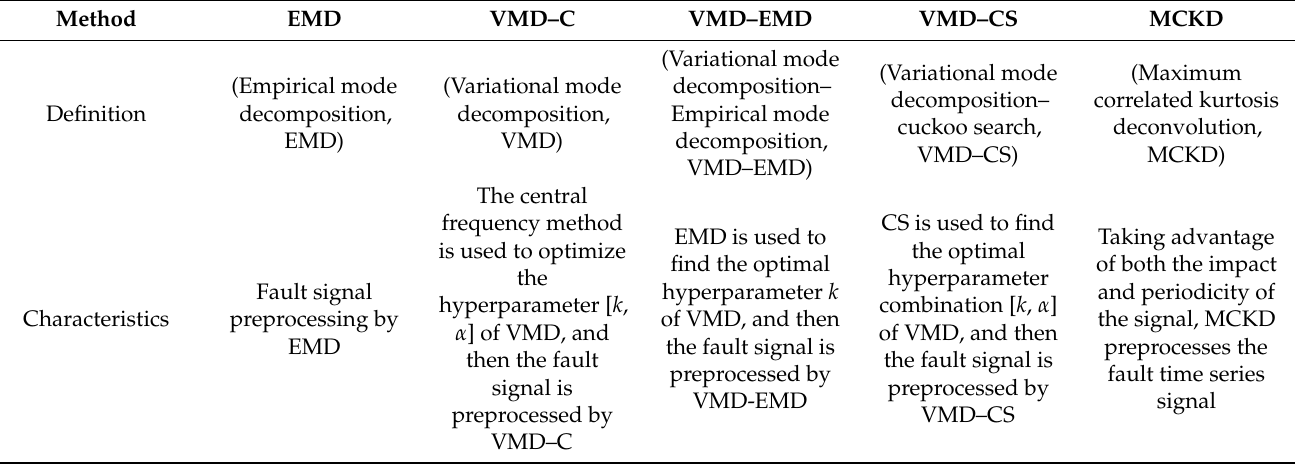
Table 2. The characteristics and definition of EMD, VMD–C, VMD–EMD, VMD–CS, and